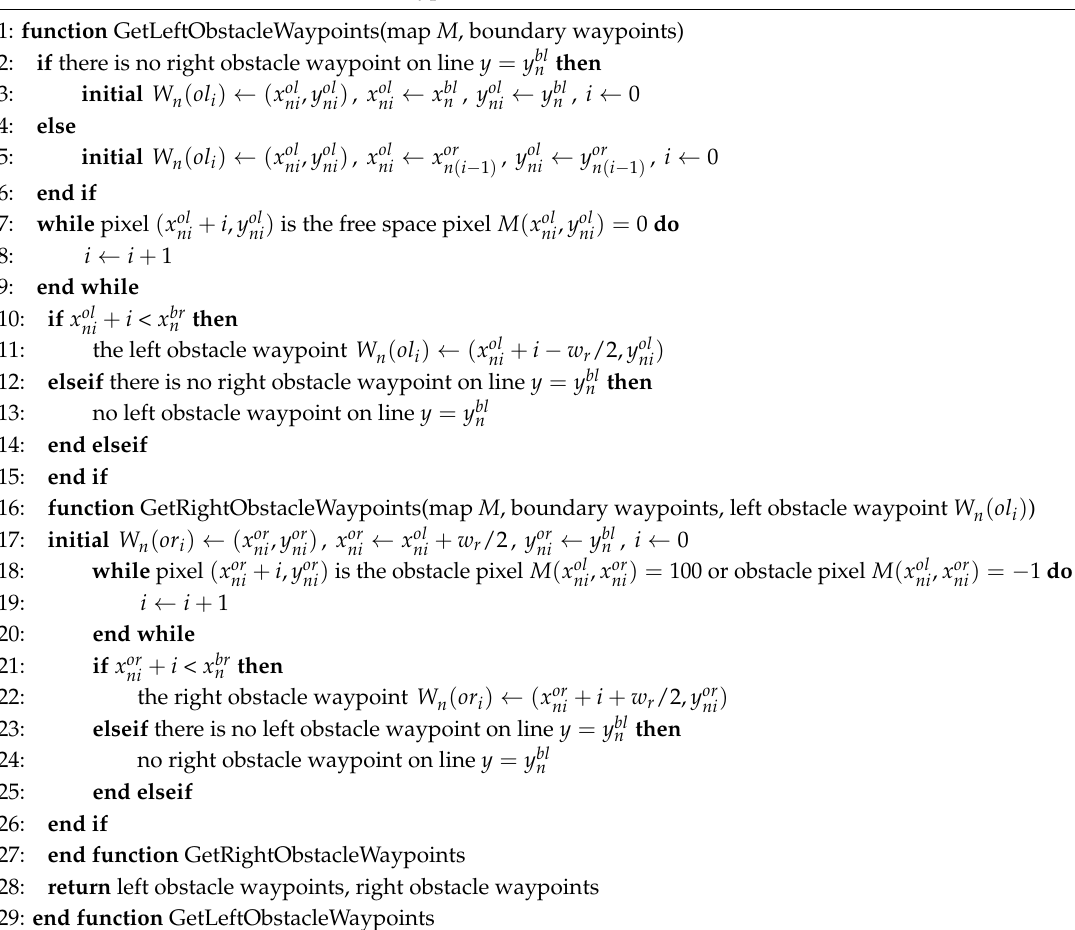
Algorithm 2 Determination of obstacle